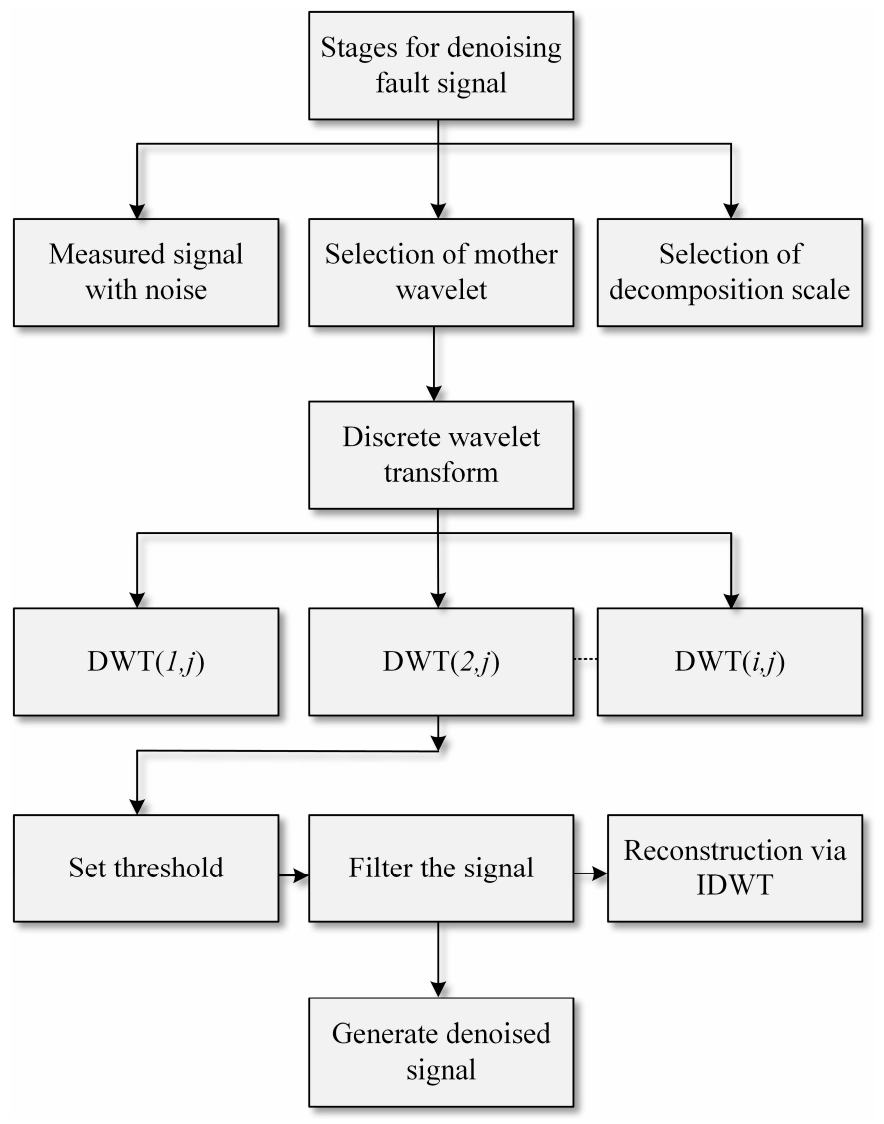
Figure 6. Signal denoising .